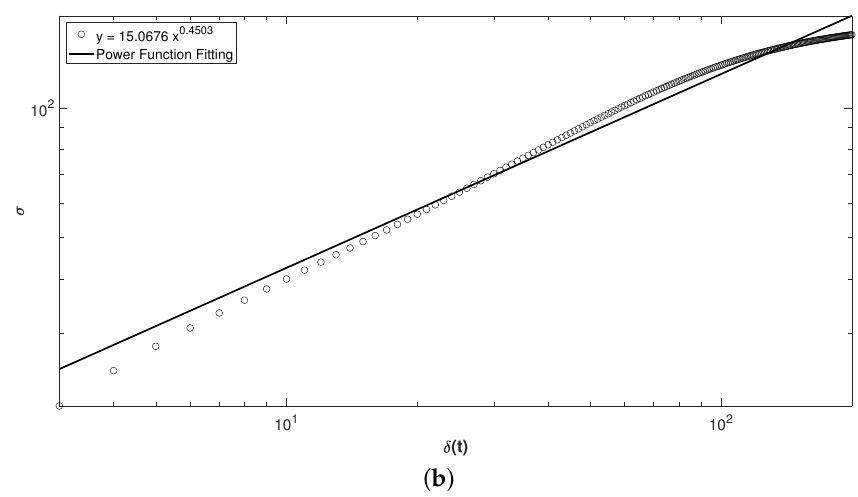
Figure 10. Whole Self-affine analysis of: ( a ) Control patient and ( b ) Intervention Patient with Obsessive Compulsive